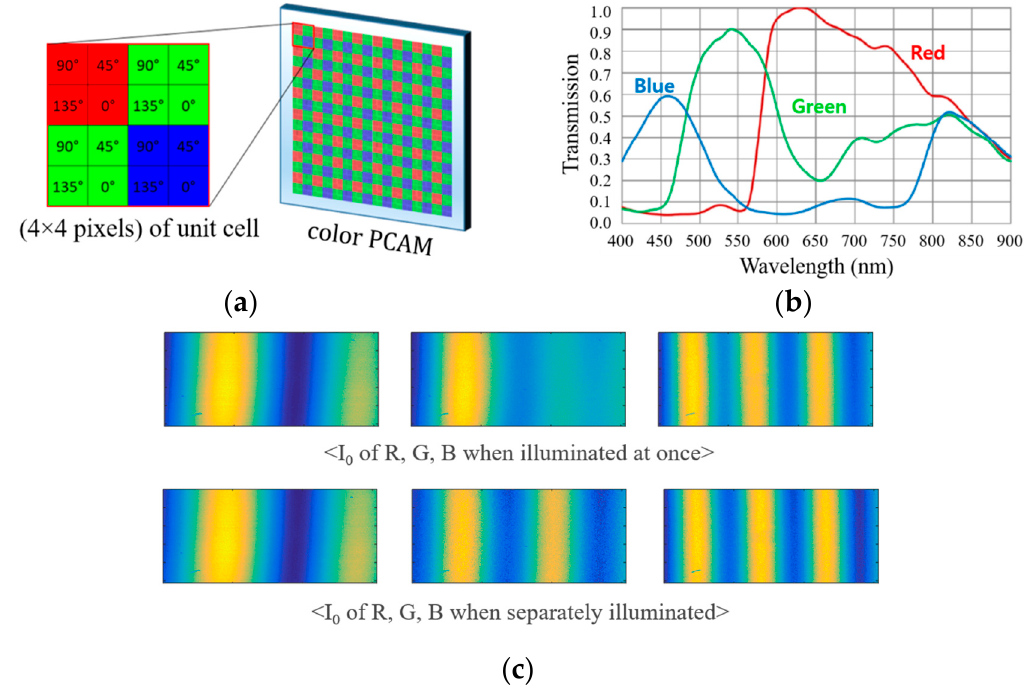
Figure 2. ( a ) Structure of a color PCAM and its unit cell; ( b ) transmission characteristics of color filter in the color PCAM; ( c ) color crosstalk in the interference fringes.